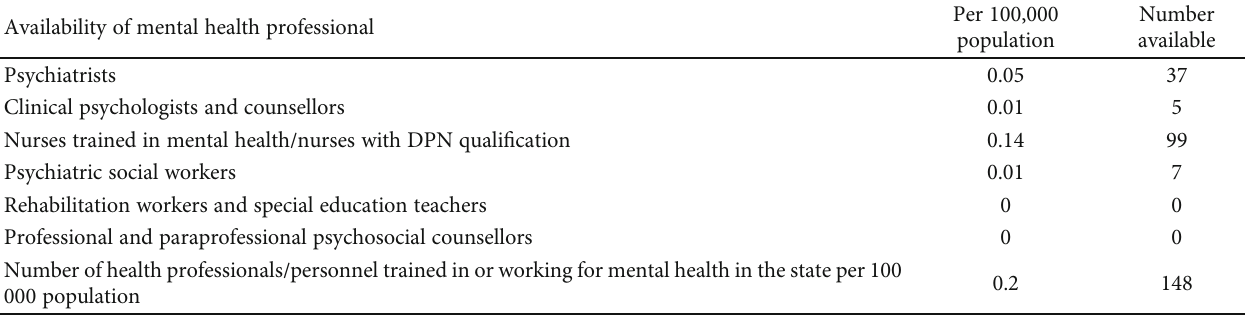
Table 3: Availability of mental health professional in Madhya Pradesh and the treatment gap (2015-16).